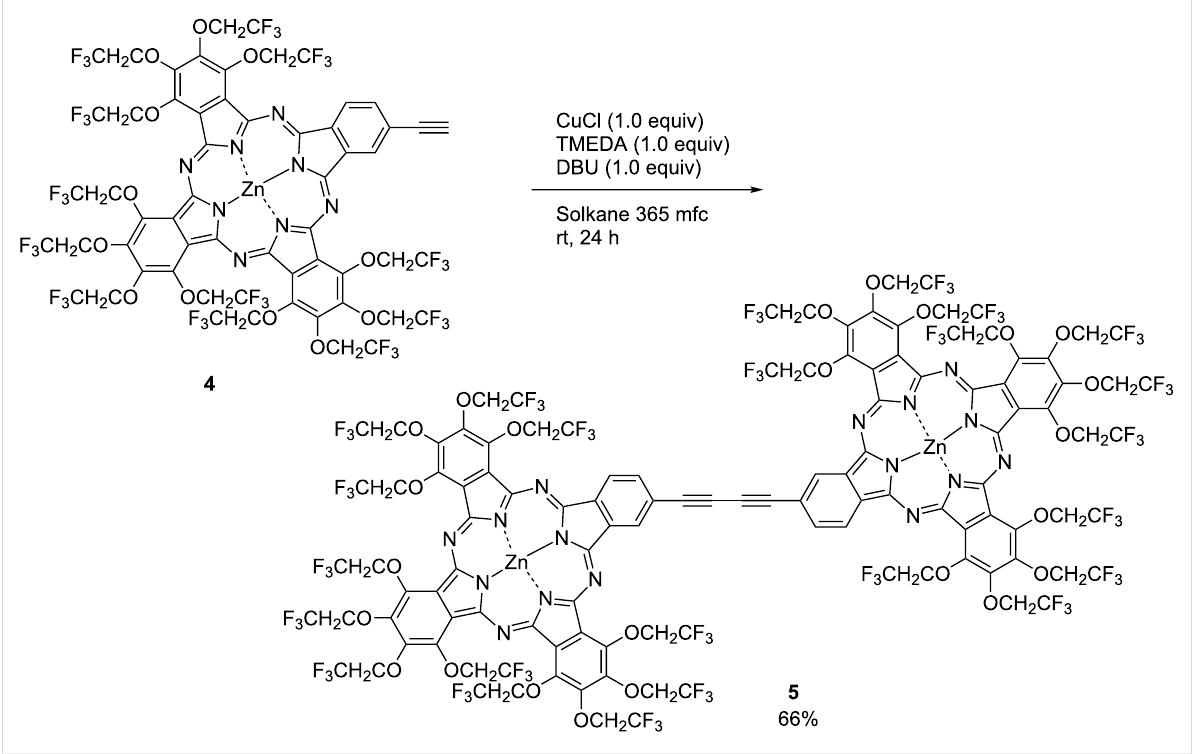
Scheme 2: Synthesis of trifluoroethoxy-substituted binuclear phthalocyanine 5 in Solkane ® 365